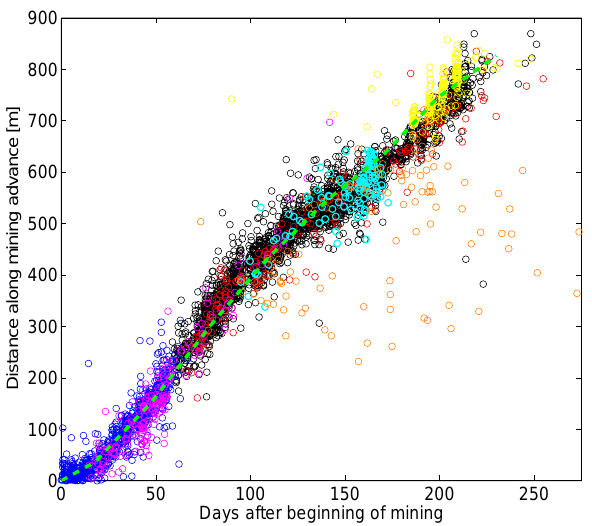
Fig. 11. Spatio-temporal migration of cluster events along the long- wall. The broken green line indicates the spatio-temporal migration of the facewall position as reported by the mine operator.